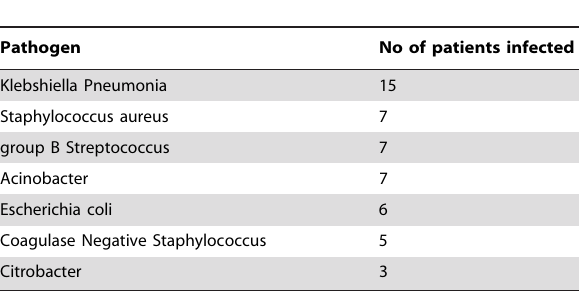
Table 2. Pathogens isolated in blood cultures from 50 patients with